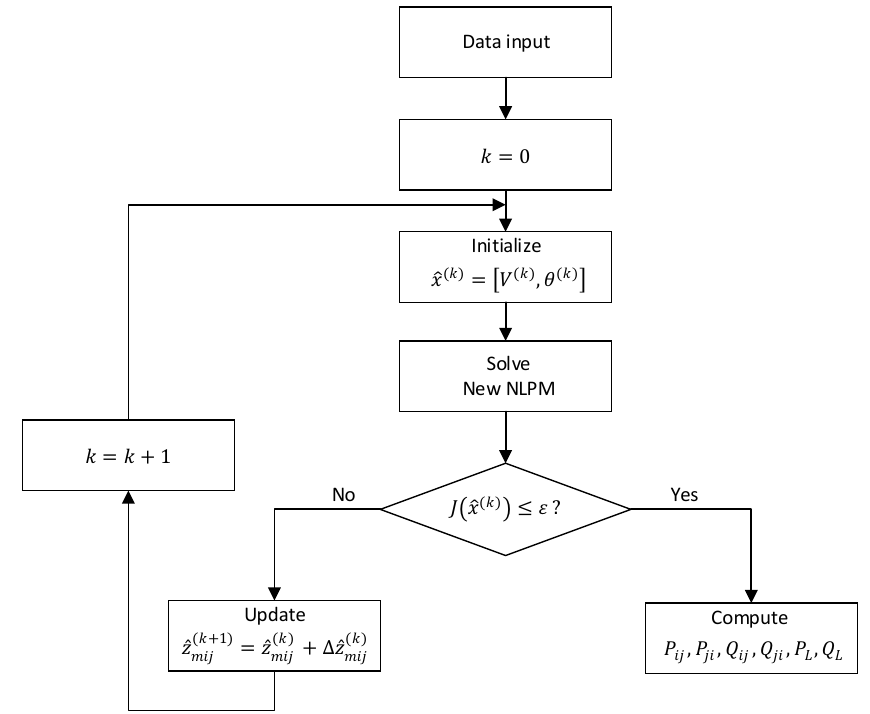
Figure 2. Proposed state estimation algorithm (New